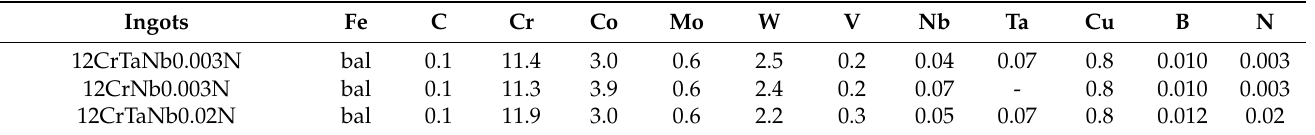
Table 1. The chemical compositions of the 12% Cr steels studied (in wt.%).